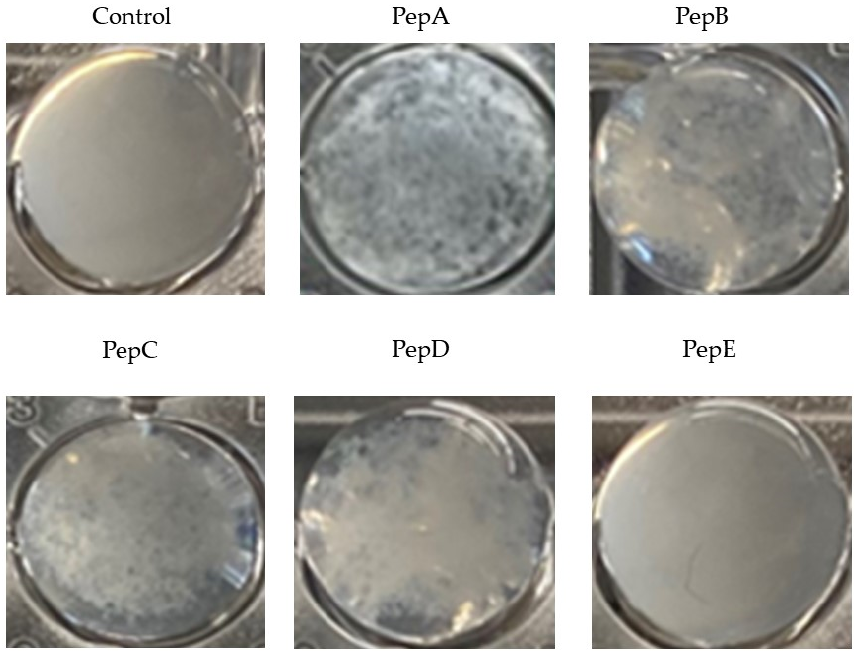
Figure 2. Macroscopic appearance of the GP340-peptide-mediated agglutination of S. aureus shown for different peptides at a concentration of 0.1 µmol/mL and PBS as control after incubations for 30 min at 37 °C in 96-well plates.